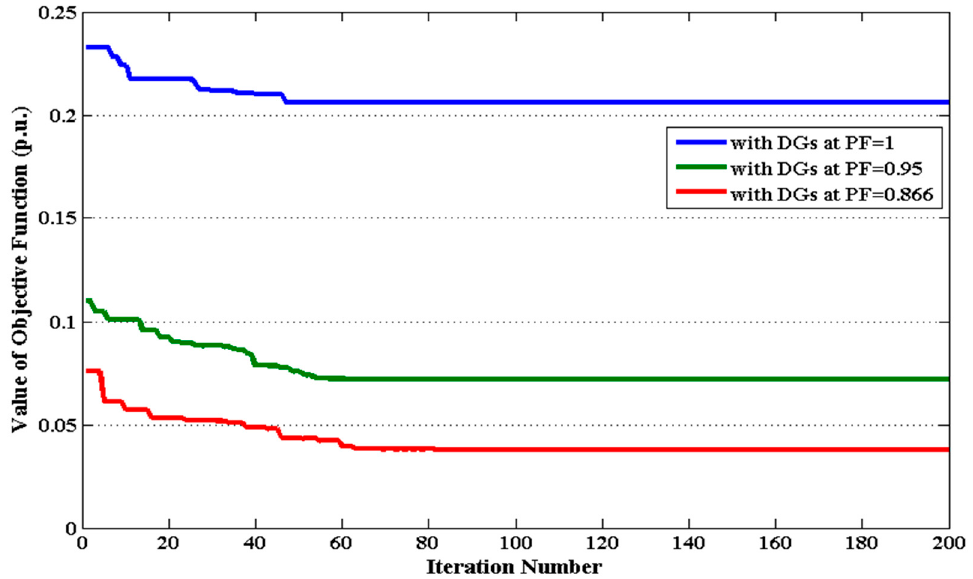
Figure 8. Convergence characteristics for Case 2 of the IEEE 33-bus system using QODELFA.